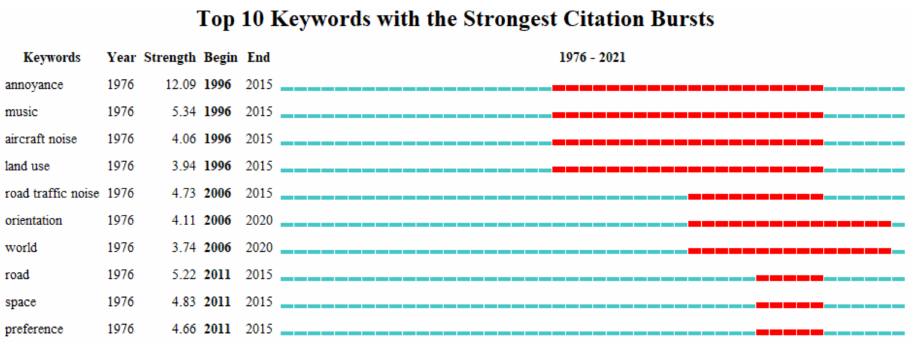
Figure 8. Top 10 keywords with the strongest citation bursts of soundscape research from 1976 to 2021.